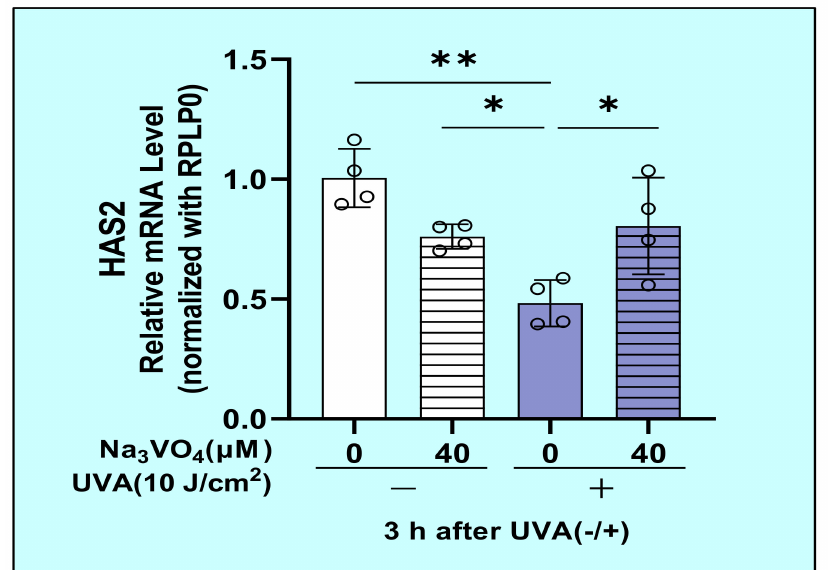
Figure 17. Effect of sodium orthovanadate on the UVA-decreased mRNA expression of HAS2 in HDFs. Sodium orthovanadate was added at 0 or 40 µ M 2 h before and immediately after UVA (10 J/cm 2 ) or sham irradiation. Cell lysate prepared at 3 h post-irradiation was subjected to RT-qPCR analysis as described in the Materials and Methods section. Data represent means ± SD., n = 4, ** p < 0.01, * p <